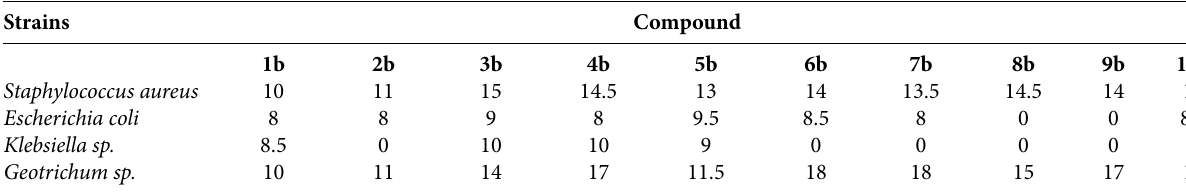
Table 1 . In vitro zone of inhibition (mm) of target oxazepine compounds. Strains